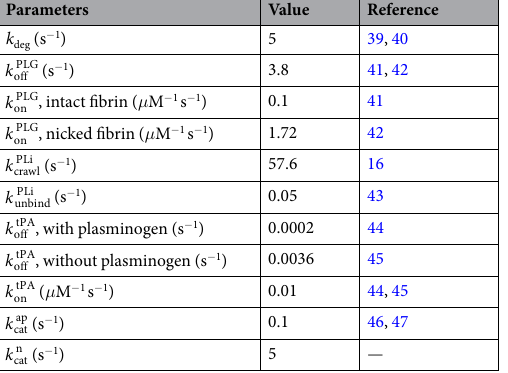
Table 1. Baseline parameter set used in the modified model. k onPLG and k offPLG are the binding rate constant for plasminogen to fibrin and the unbinding rate constant for plasminogen from fibrin, respectively, with dissociation constant = K k k / dPLG offPLG onPLG . The tPA rate constants have similar meanings. K dPLG is different depending on whether fibrin is intact or nicked, and K dtPA is different depending on whether tPA is bound to a doublet with or without plasminogen. k catap is the catalytic rate constant for activation of plasminogen to plasmin, k catn is the catalytic rate constant for plasmin-mediated exposure of cryptic binding doublets, and k deg is the PLi and k PLi are the crawling rate constant and plasmin-mediated rate constant for fibrin degradation. k crawl unbind unbinding rate constant of plasmin, respectively. We know the dissociation constants for tPA and plasminogen, but not the individual rate constants, so references in the table are for K d . We assume that = k k catn , since we deg have not found any references for the rate of plasmin-mediated exposure of binding